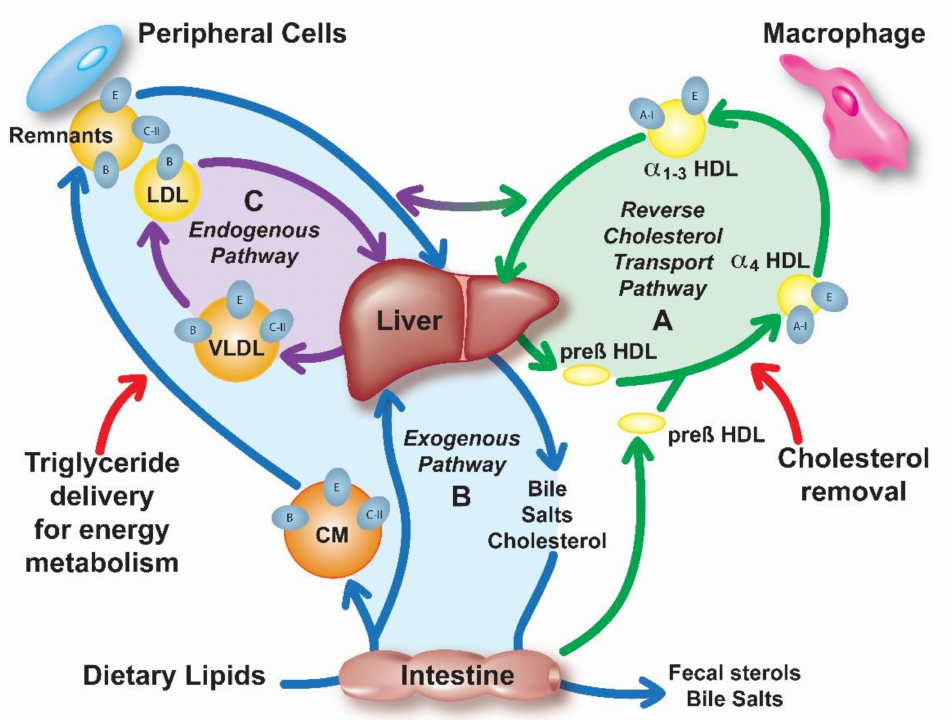
Figure 1. Overview of lipoprotein metabolism. Lipoprotein metabolism consists of three pathways: ( A ) Reverse cholesterol transport (RCT) (green); High-density lipoproteins (HDL) remove excess cellular cholesterol from peripheral tissues and macrophages and deliver it to the liver for excretion into the bile or for reutilization. ( B ) Exogenous pathway (blue); Dietary lipids are absorbed in the intestine and secreted into circulation in a form of chylomicron (CM) particles, which contain apoB-48, apoE and apoC-II. Triglycerides (TG) of CM are hydrolyzed by lipoprotein lipase (LPL), which requires apoC-II, forming remnant particles that are removed by the liver by apoE-mediated binding to low-density lipoproteins (LDL)-receptor (LDLR), LDLR-related protein (LRP) or heparan sulfate proteoglycan (HSPG). Free fatty acids from TG lipolysis are taken up by the peripheral tissues for energy production or storage. ( C ) Endogenous pathway (purple); Very low-density lipoproteins (VLDL) containing TG in their core and also apoB-100, apoE and apoC-II are secreted from the liver into circulation where they undergo LPL lipolysis forming remnants and LDL particles, which